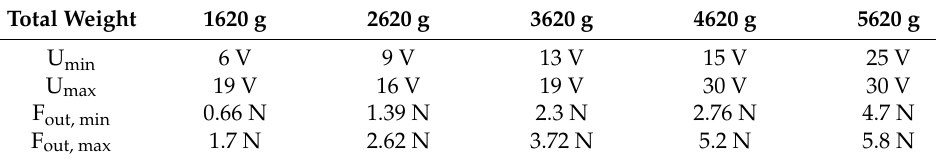
Table 5. Appropriate operating ranges for force in the +Y direction.